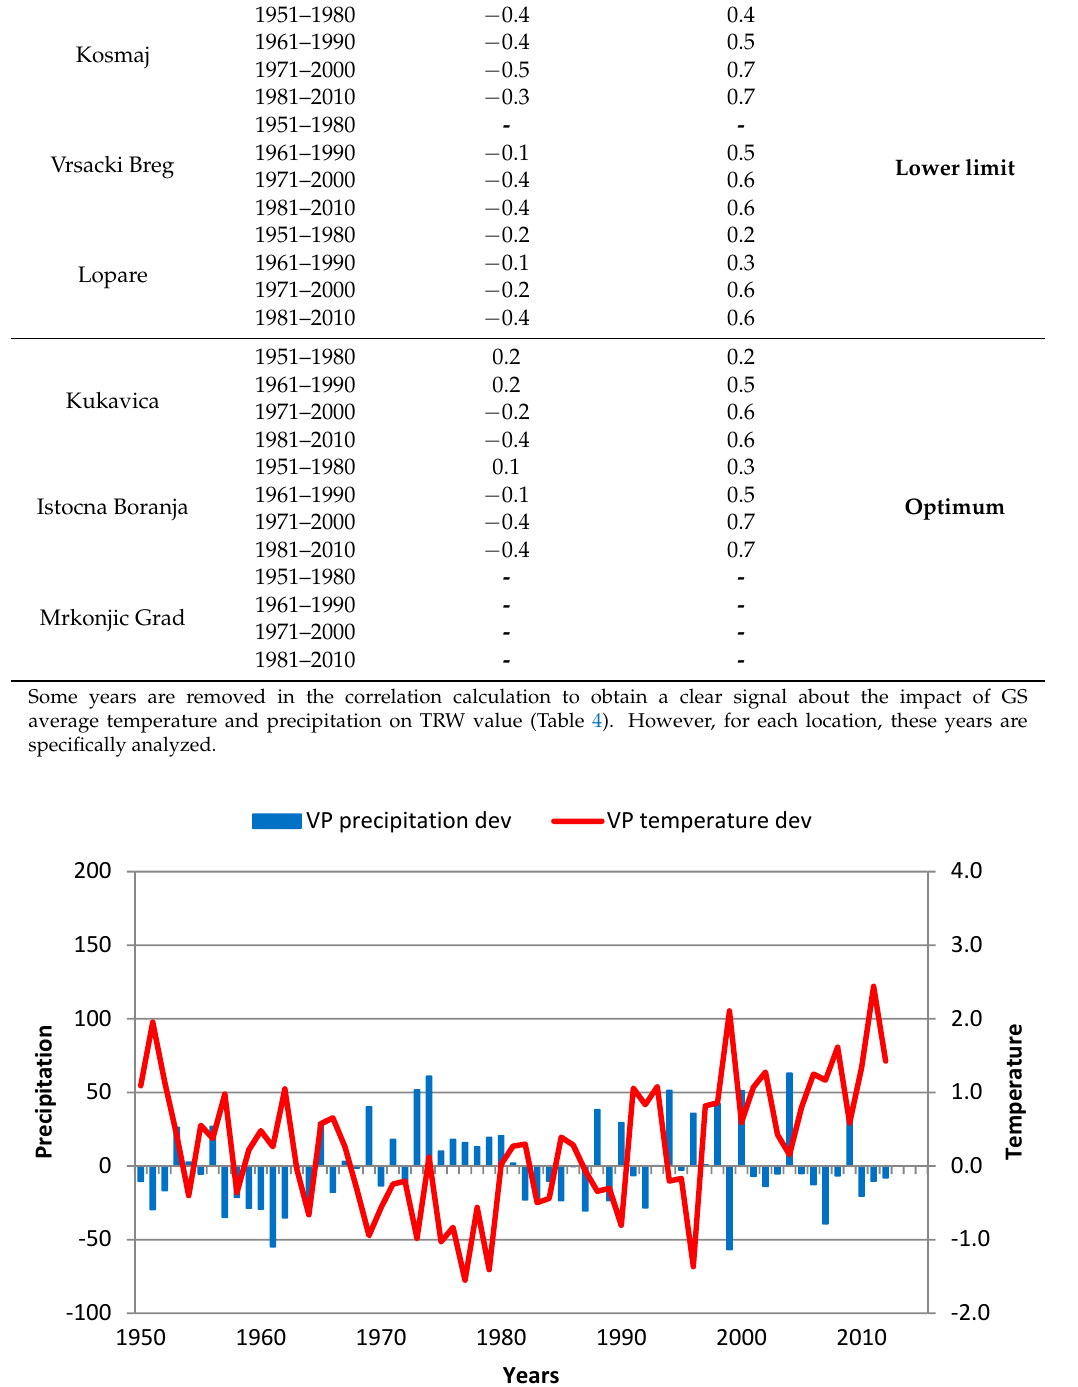
Figure 8. GS precipitation and temperature deviations in Vrsacki Breg over the 1951–2013 period. Red line—GS temperature deviation; blue bar—GS precipitation deviation.